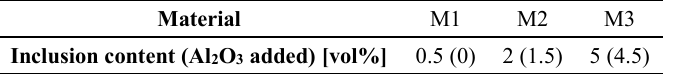
Table 1. Overview of simulated inclusion contents.